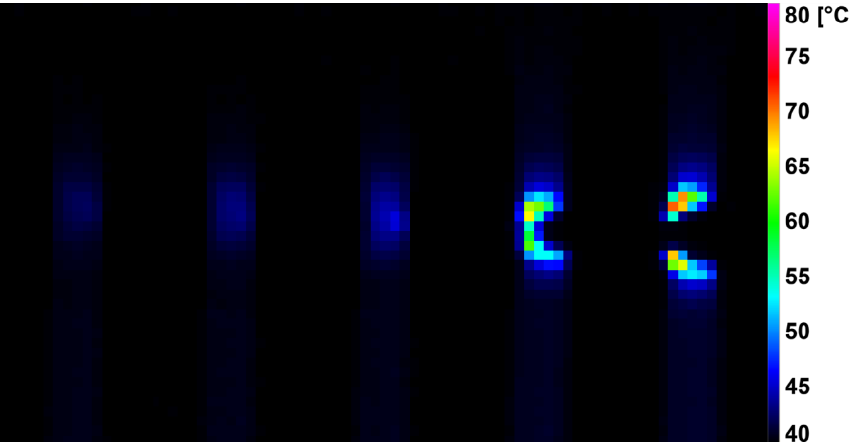
Figure 8. Deformation process of 110 °C_H7 evaluated using IR thermography.